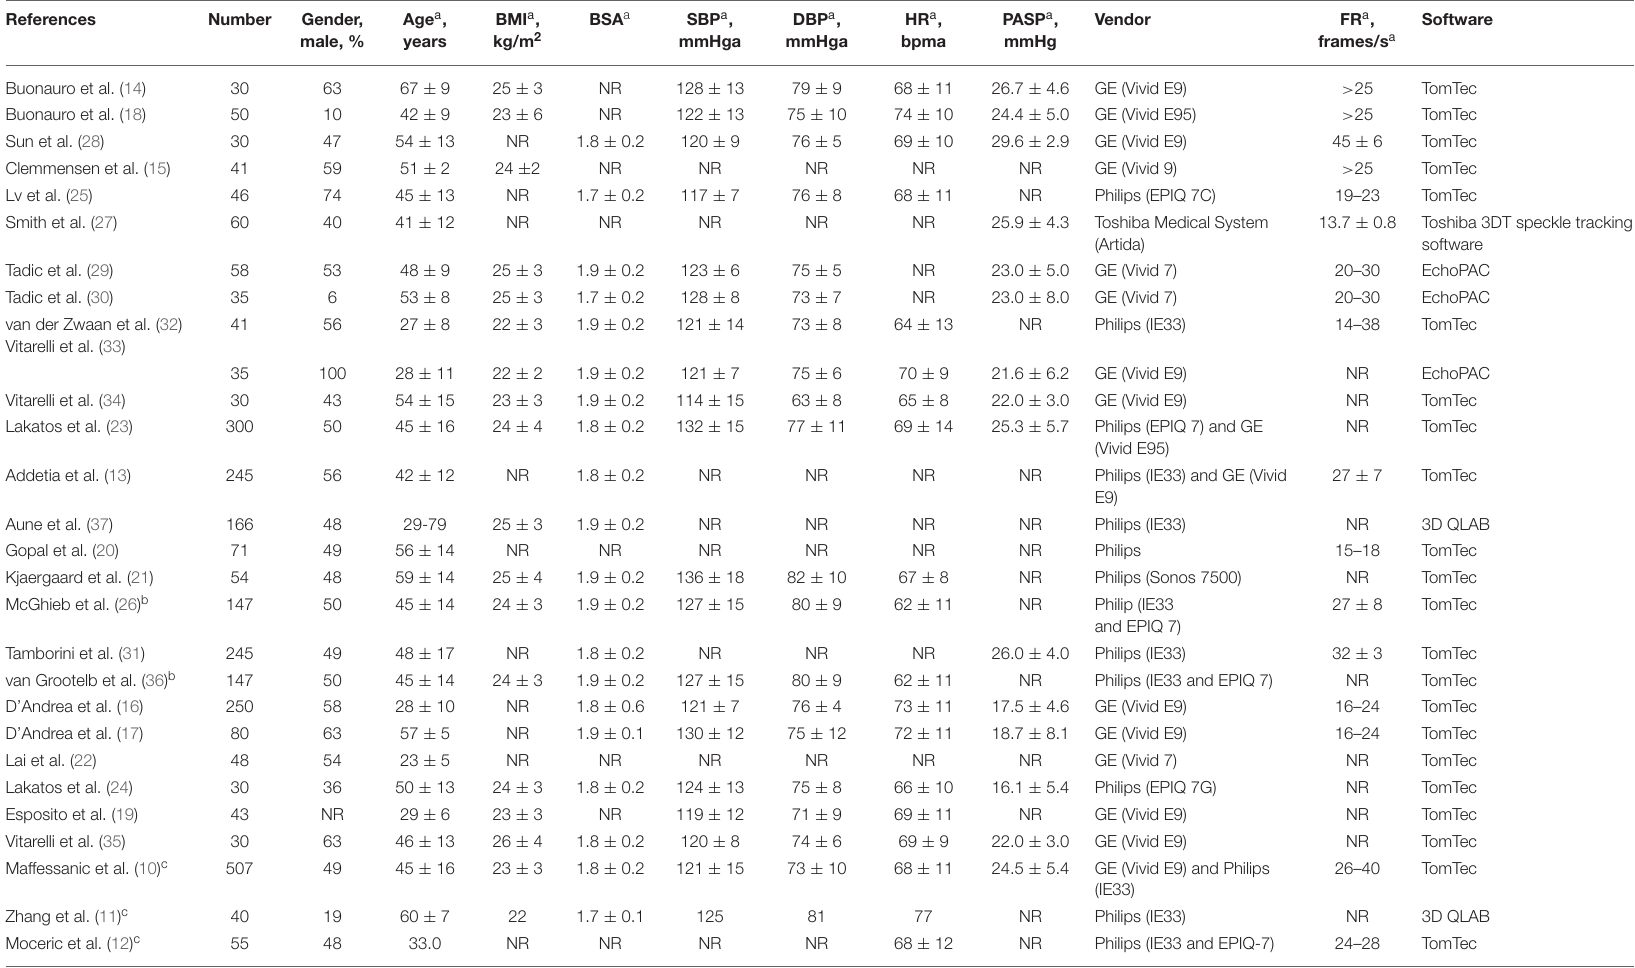
TABLE 1 | The baseline characteristics of the included